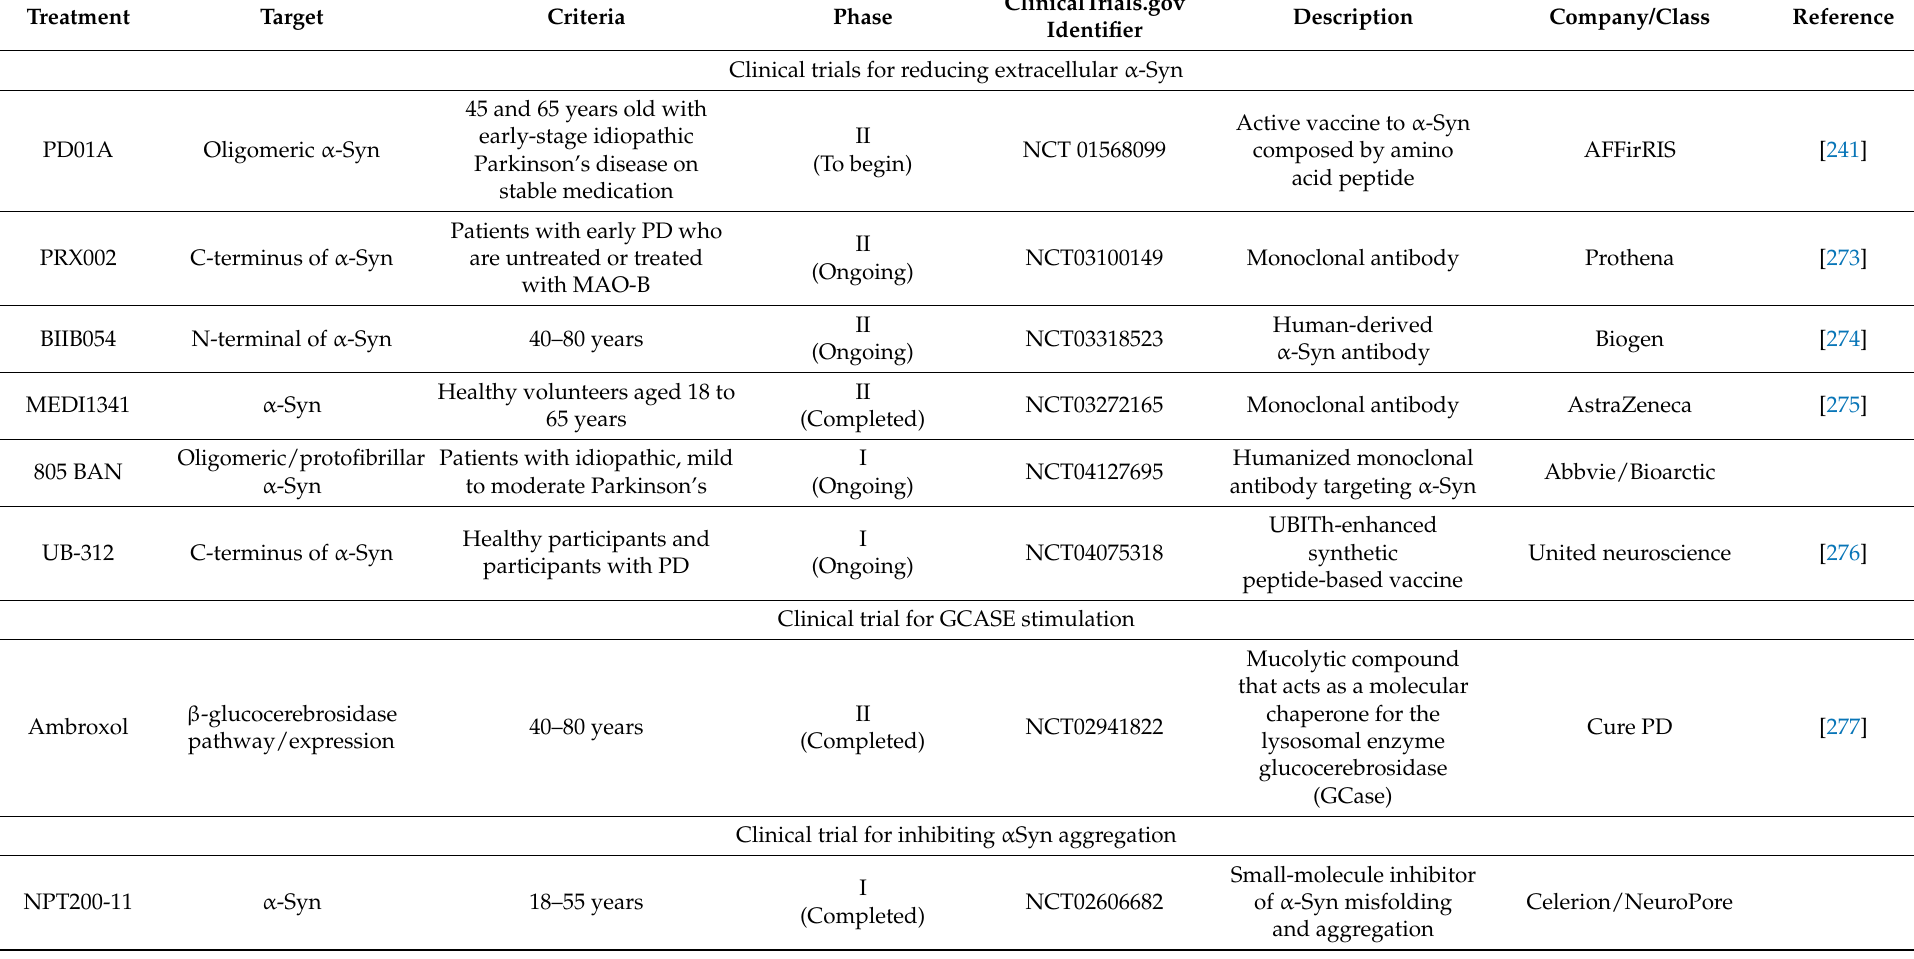
Table 2. Pharmacotherapies tested in clinical trials with Parkinson’s disease patients (ClinicalTrials.gov, accessed on 1 May